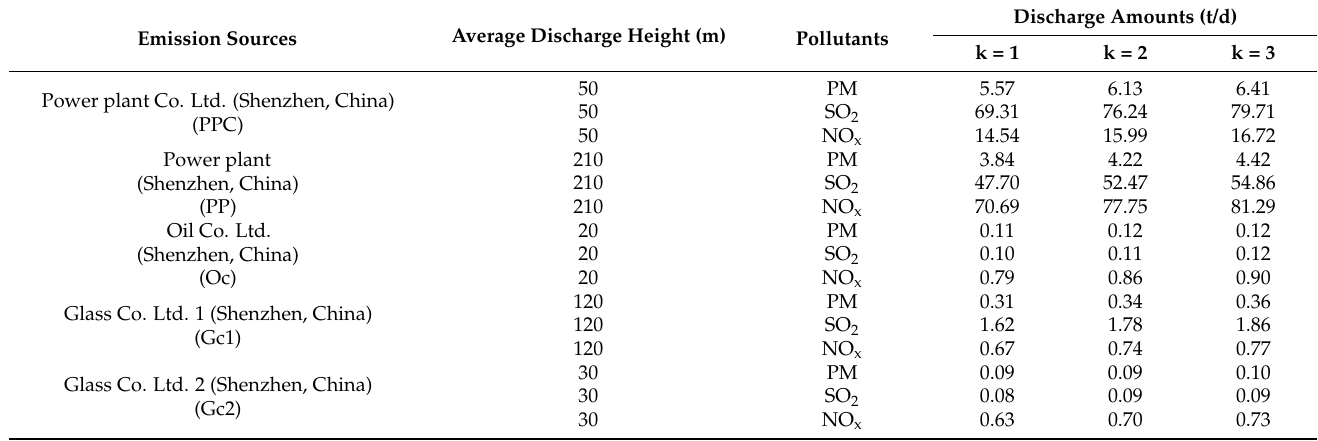
Table 2. The parameter information related to the five emission